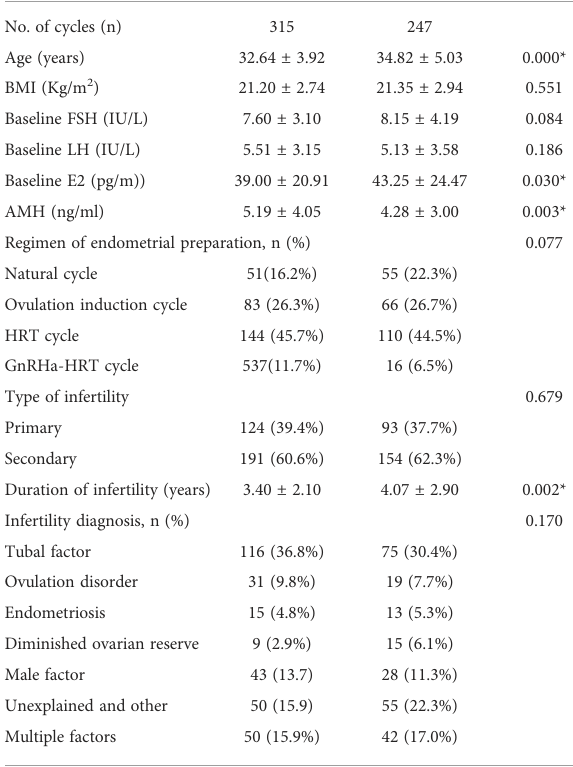
TABLE 1 Baseline characteristics in women according to whether clinical pregnancy was